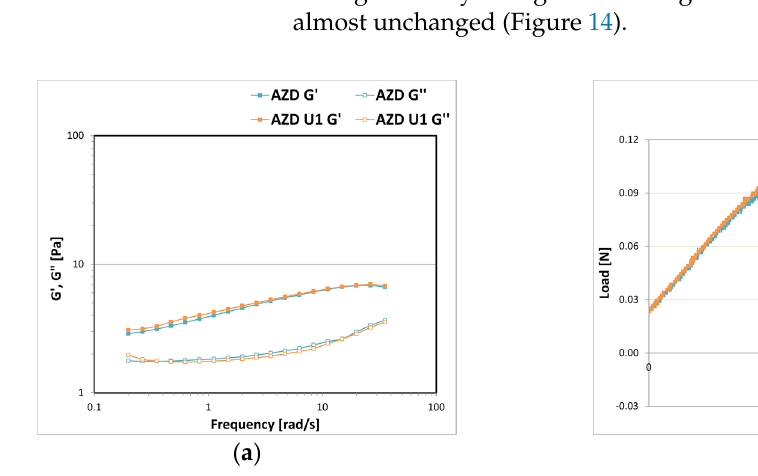
Figure 14. Storage G’ and loss G’’ moduli trend as a function of the oscillation frequency ( a ) and texture curves obtained from an immersion/de-immersion test ( b ) for the emulsions prepared with A-Z associations (ratio 1:1) at a total solid amount of 10% w/w, D at 0.3% w/w, an oily phase at 9% w/w with and without 9% w/w of sun filters mixture U.